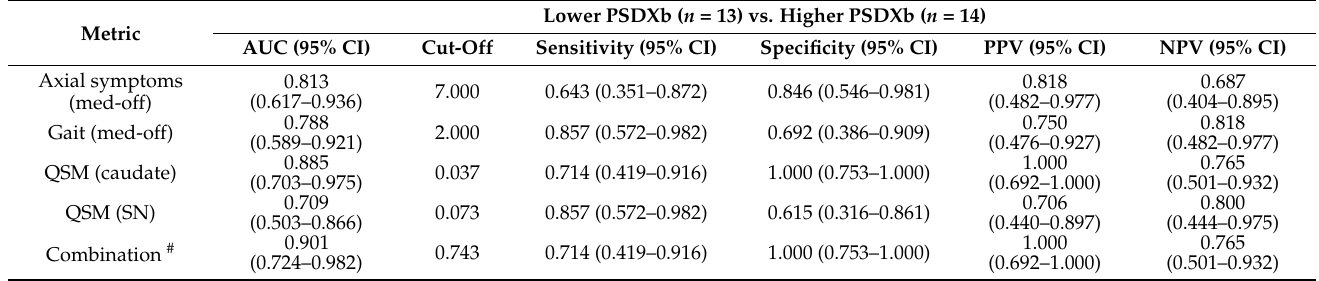
Table 4. Results of ROC analyses of the significant features used to separate different PSDXb